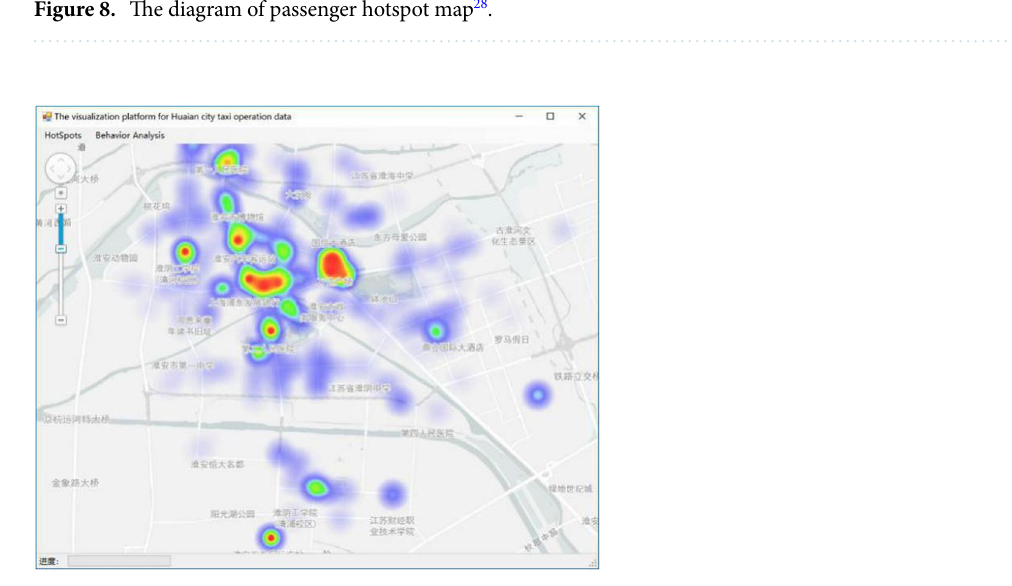
Figure 9. The diagram of thermal diagram visualization effect 28